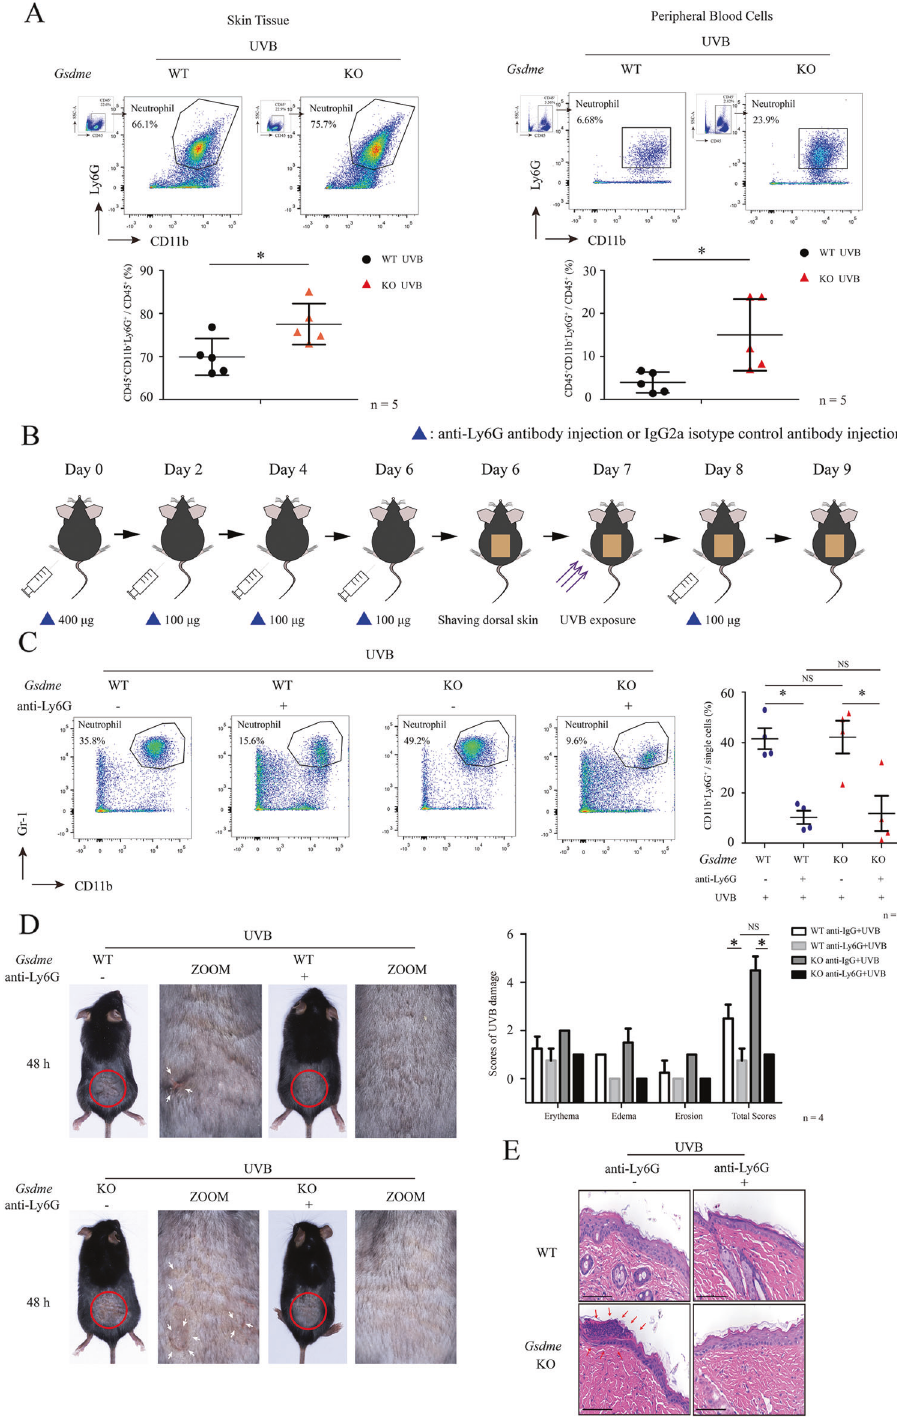
Fig. 6 Depleting neutrophils eliminates the aggravation of UVB-caused skin damage in Gsdme − / − mice. A Recruitment of neutrophils in the skin or peripheral blood at 72 h after UVB exposure were analyzed by fl ow cytometry. The frequency of CD11b + Ly6G + cells in CD45 + gated live cells were used for quantitative analysis ( n = 5). Detailed gating strategy was shown in Supplementary Fig. S5. B The fl owchart shows the process in the experiment of UVB-challenged WT mice and Gsdme − / − mice with anti-Ly6G injection. C Representative dot plots of CD11b + Gr-1 + neutrophils in peripheral blood of different groups of mice. Quanti fi cation analysis was performed by FlowJo software. D Images showed the skin appearance at 48 h after UVB exposure. Skin damage was evaluated by scores. The details of scores were described in “ Materials and methods ” . The white arrow indicates epidermal destruction. E Representative images of H&E staining present the histological features. Red arrow indicates epidermal necrosis. Scale bar presents 100 μ m. F Level of keratinocyte death was determined by PI staining. Wide spectrum Cytokeratin was used to indicate keratinocytes. The scale bar represents 100 μ m, n = 4. G MPO, MMP-9, and NE were detected in skin tissue through immunohistochemistry assay. Scale bar represents 100 μ m. * P < 0.05. NS nonsense.